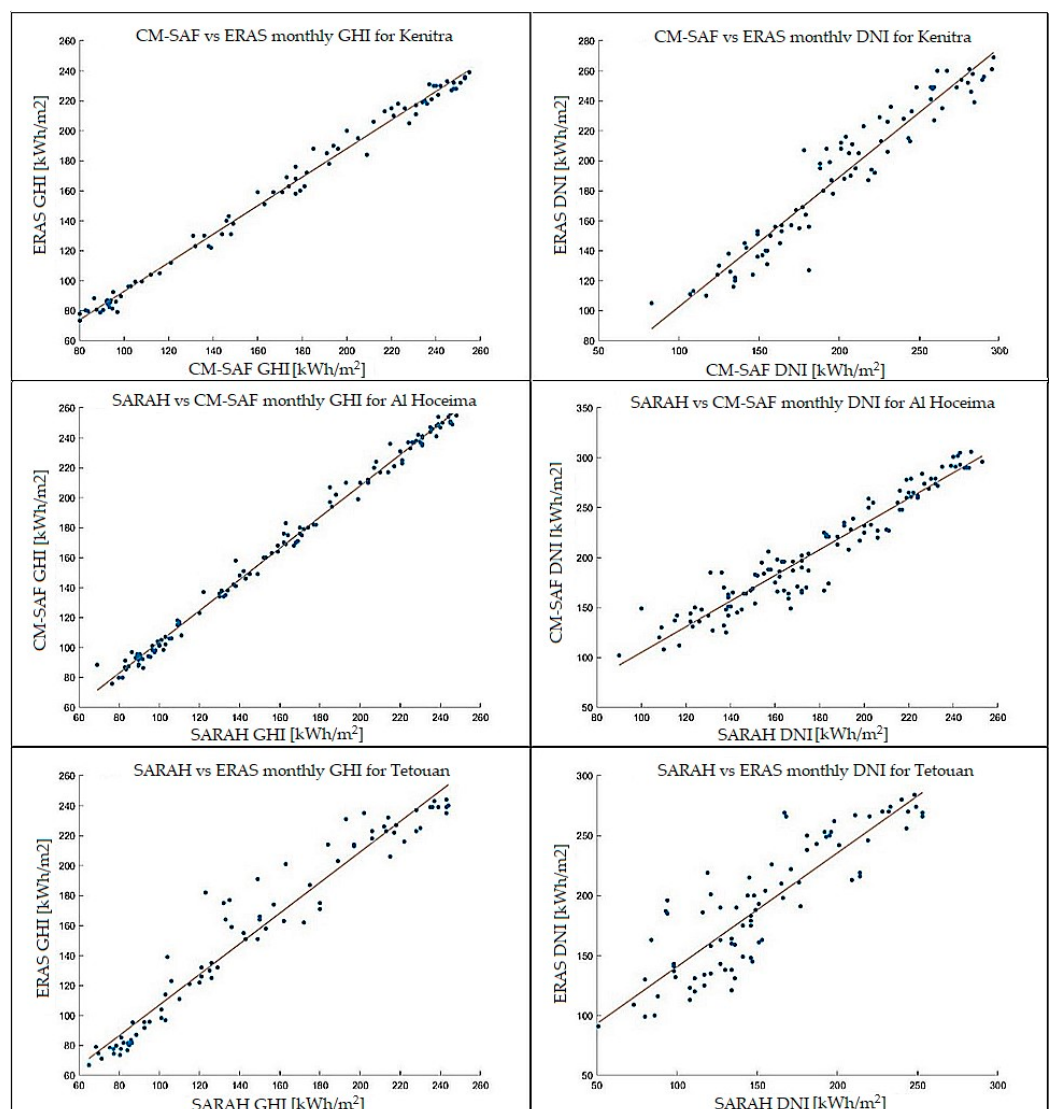
Figure 5. Monthly irradiation values within the analyzed time intervals comparing pairs of databases and linear regression for the validation of data. Source: own elaboration.